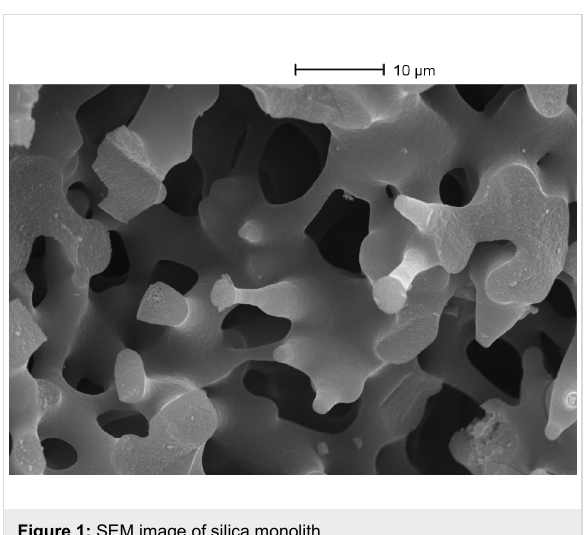
Figure 1: SEM image of silica